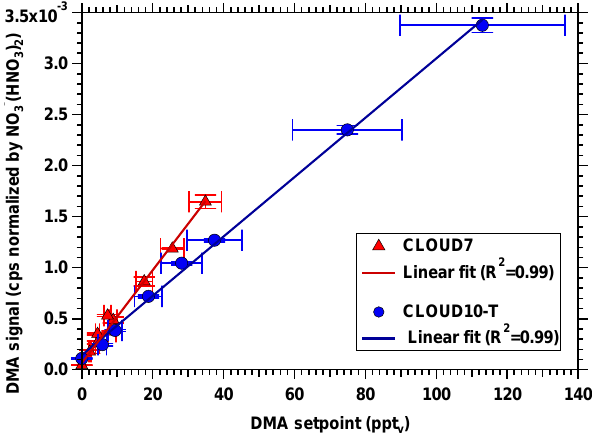
Figure 5. Calibration curves for the average DMA signals as a function of the DMA mixing ratio during CLOUD7 (red symbols) and CLOUD10-T (blue symbols). The lin- ear fit for the CLOUD7 calibration follows the expression y = 9.13 × 10 − 5 + 4 . 41 × 10 − 5 pptv − 1 × x . The expression for the linear fit of the CLOUD10-T (blue) calibration follows y = 14.35 × 10 − 5 + 2.91 × 10 − 5 pptv − 1 × x . Error bars for the DMA set-point values are based on a ± 5% uncertainty for each of the MFC flow rate settings and the standard deviation of the fit parameter for k wall . The errors for the measured DMA signals are based on the standard deviation of the